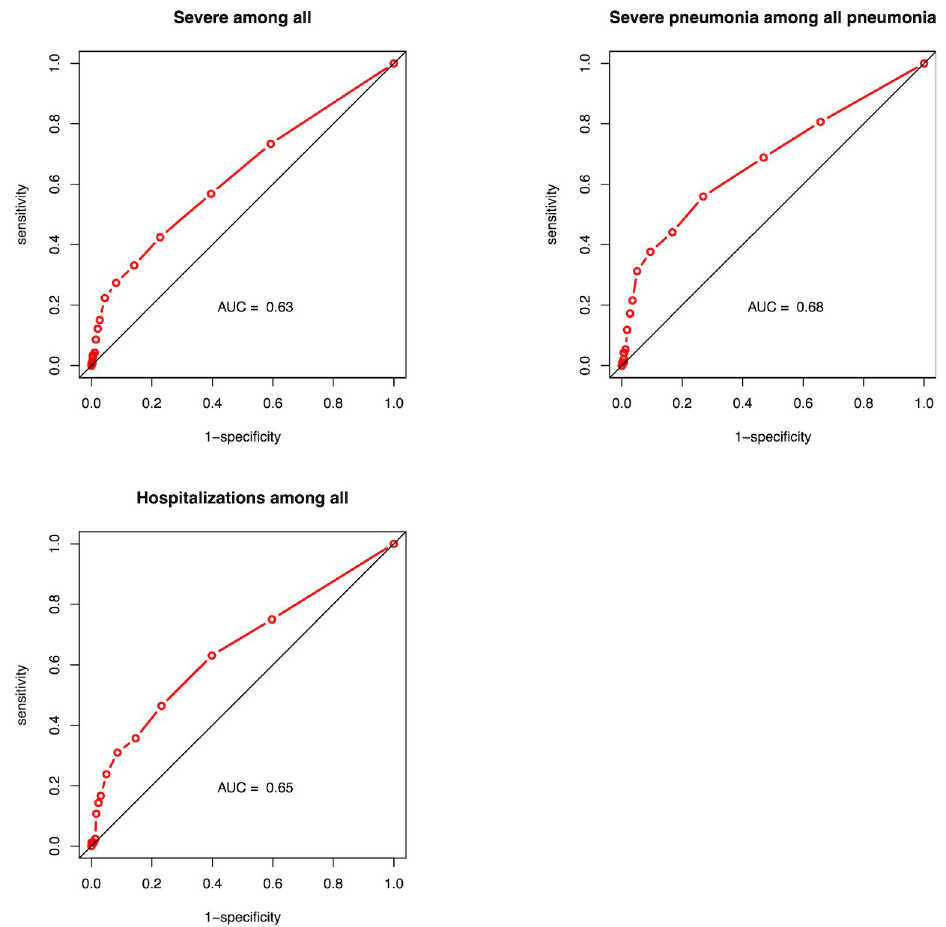
Fig 3. ROC curves to predict: Severe diseases among all illness episodes, severe pneumonia among all pneumonias episodes and hospitalizations among all illness episodes.